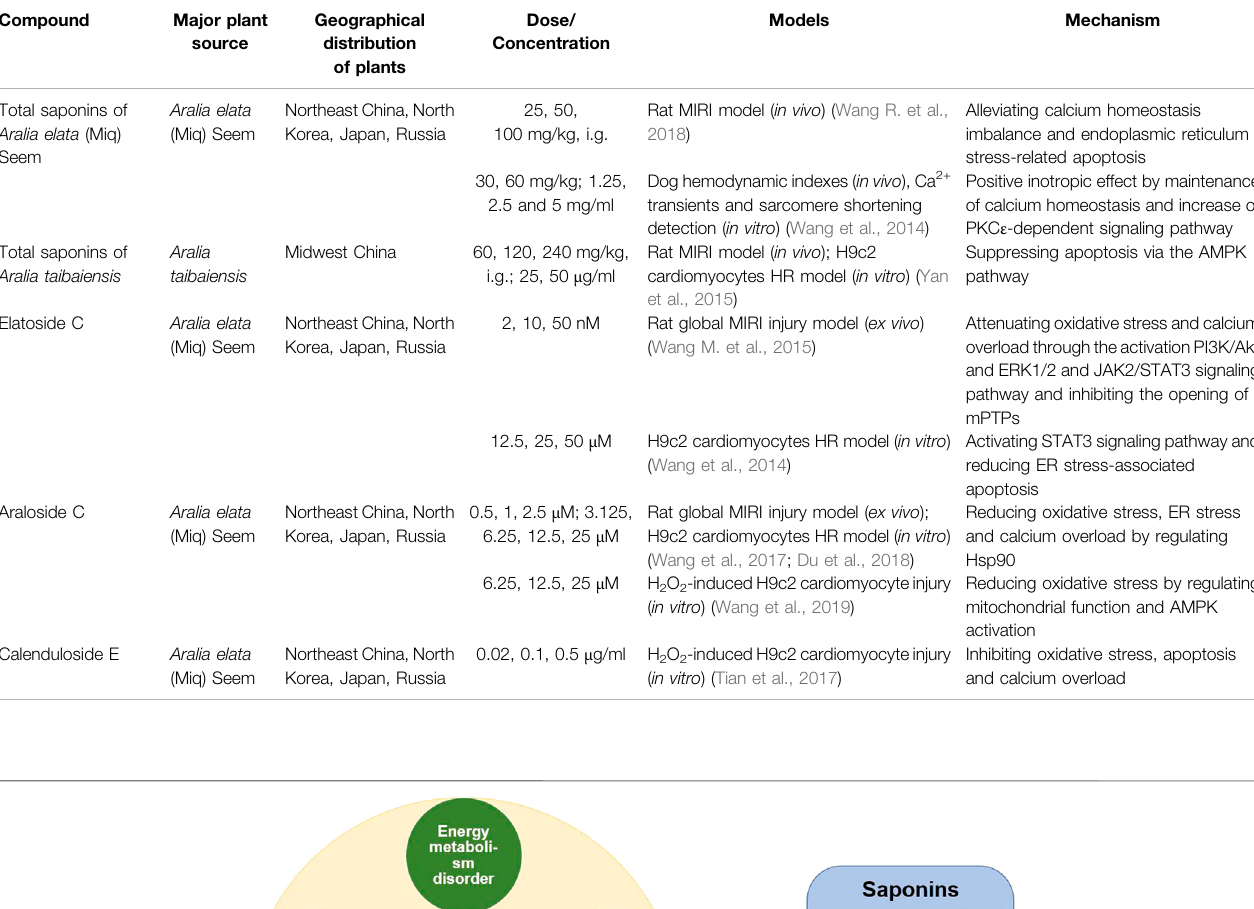
TABLE 2 | Anti-MIRI effects of saponins from Aralia .